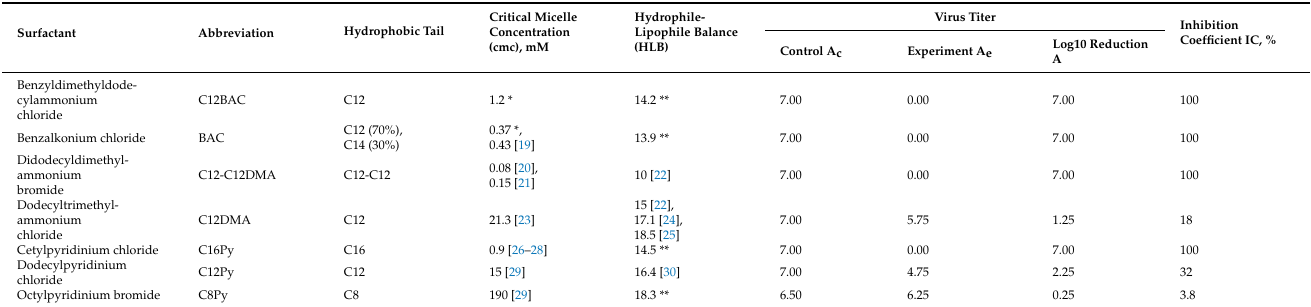
Table 1. SARS-CoV-2 inactivation by 0.28 mM solutions of different cationic surfactants (contact time 1 h).